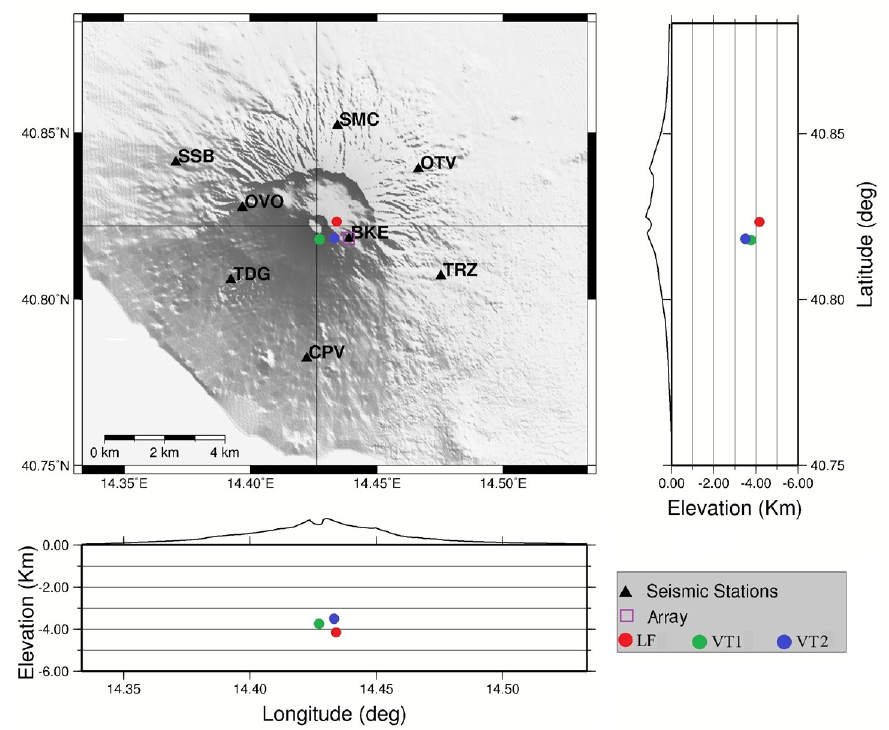
Figure 1. Mt. Vesuvius map, with the position of the seismic stations that recorded at least one of the three analyzed seismic events and the epicenters of these earthquakes according to the legend in the bottom-right corner. On the right side the depth of the three events is repre- sented on the NS-section of the volcanic edifice. The EW-section is shown at the